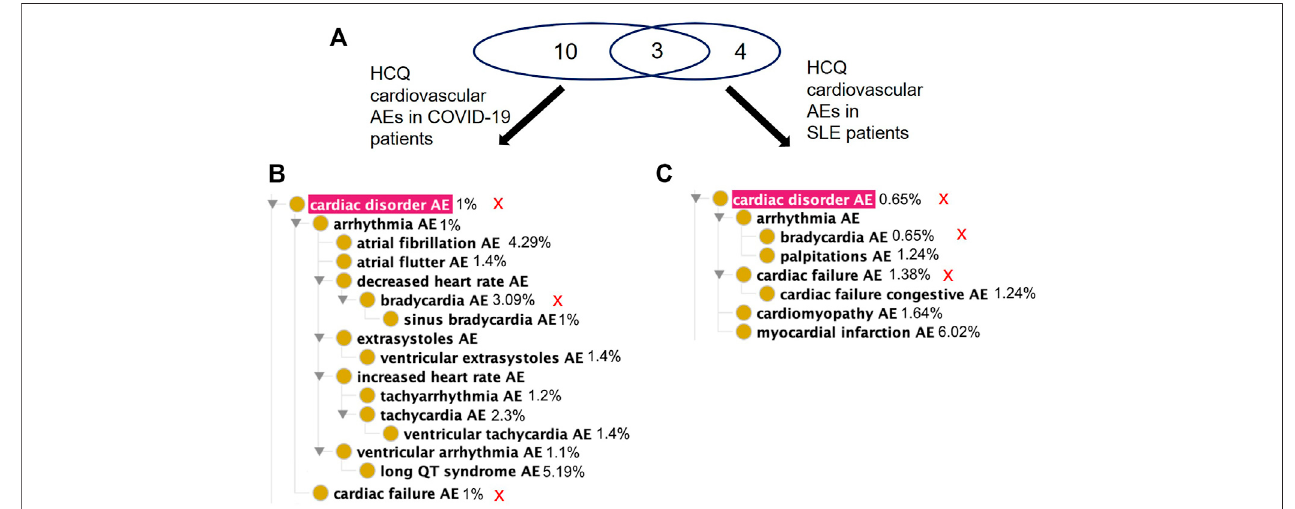
FIGURE 5 | Comparison of signi fi cant cardiac AEs for COVID-19 and SLE patients treated with HCQ from the FAERS database. (A) Venn diagram of signi fi cant cardiac AEs for COVID-19 and SLE patients treated with HCQ. (B) OAE classi fi cation of signi fi cant cardiac AEs for COVID-19 patients treated with HCQ. (C) OAE classi fi cation of signi fi cant cardiac AEs for SLE patients treated with HCQ. The percentages next to the AE terms represent the occurrence rates of these AEs under the speci fi c condition. The red sign of “ X ” next to the AE terms in (B,C) represent the shared AE for the two types of patients. Different cardiac AEs were found to be associated with HCQ following its usage for treating COVID-19 and lupus.